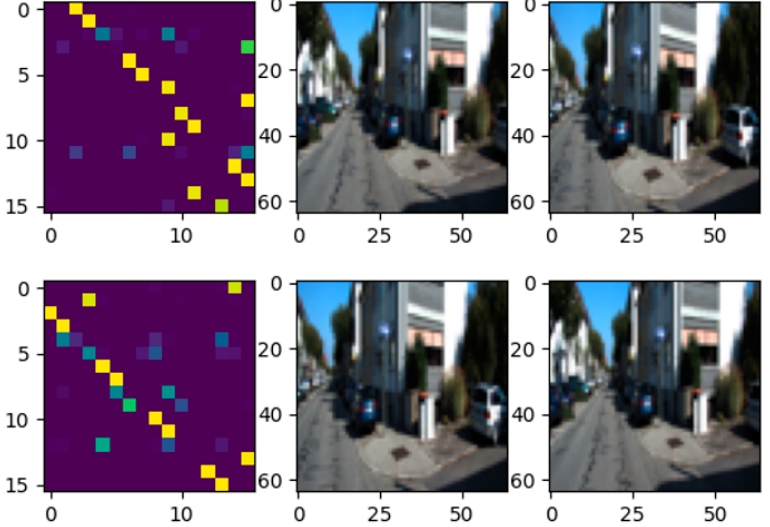
Figure 6. Correlation distribution φ in the case of camera rotation: top, the change in the φ when the camera is rotated to the right; bottom, the change in the φ when the camera rotates to the left.